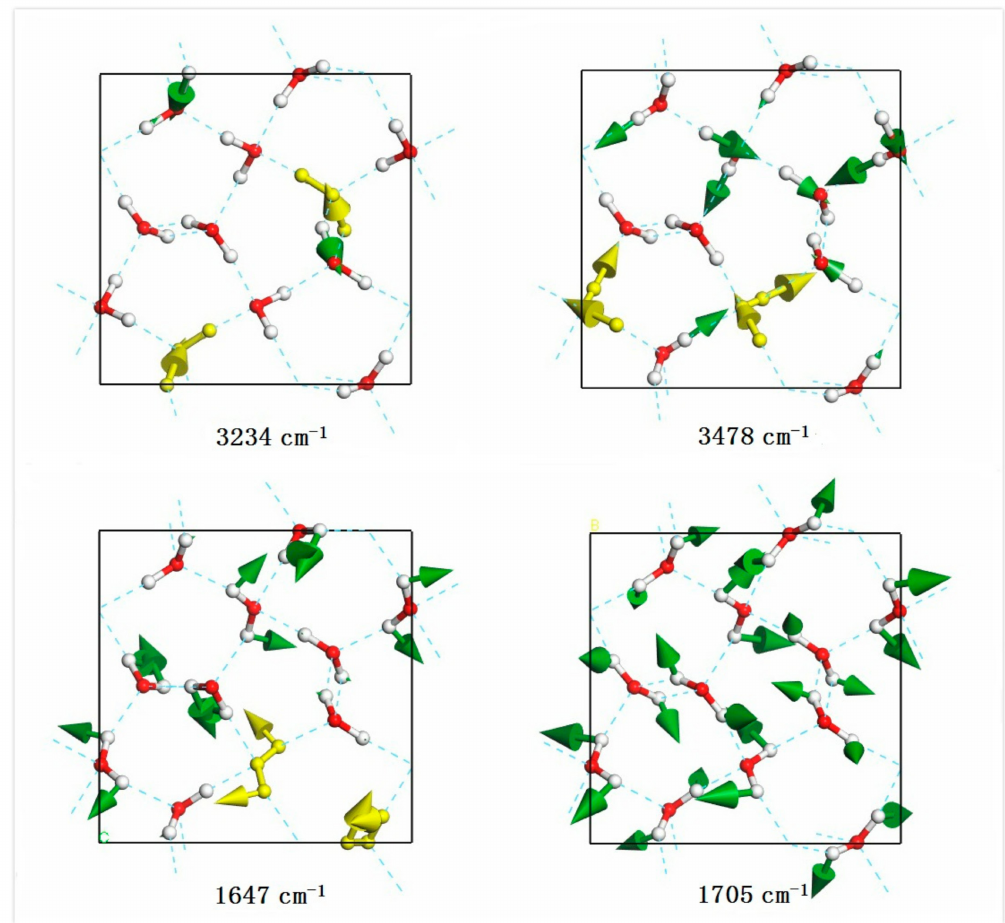
Figure 2. A top view of four normal vibration modes in the stretching band (3234 cm − 1 , 3478 cm − 1 ) and bending band (1647 cm − 1 , 1705 cm − 1 ), respectively. Typical vibrations are represented in gold. The green arrows represent the vibration direction in sizes proportional to the vibration